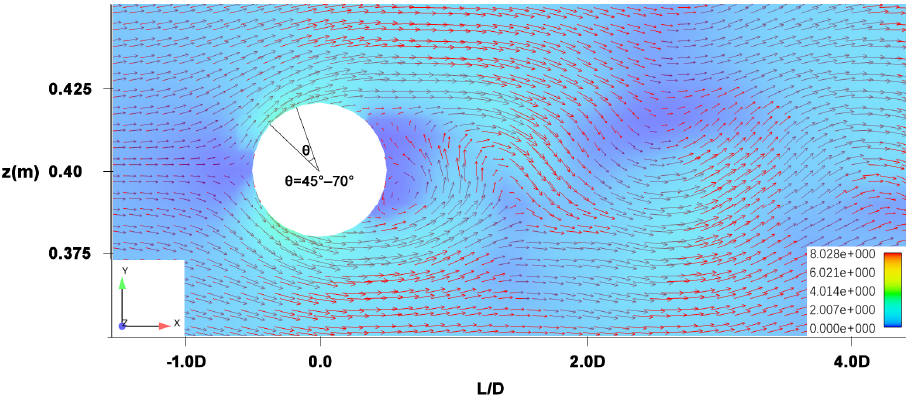
= 0.002 m, t = 50 s) (unit: